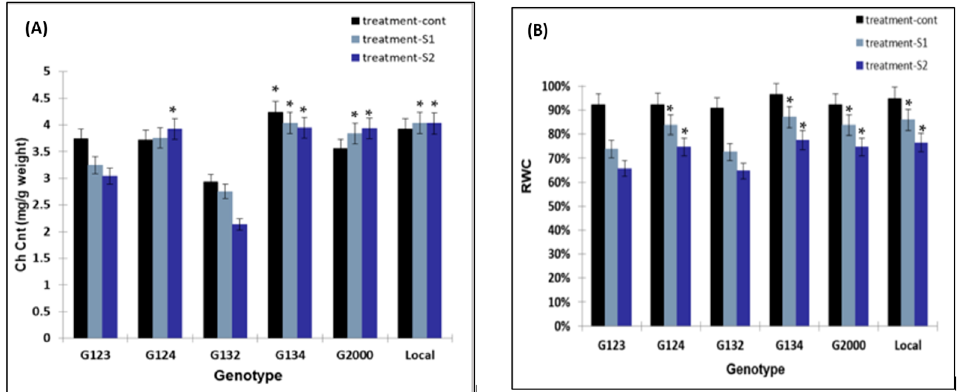
Figure 3. The effect of different NaCl concentrations on the chlorophyll content of the leaves ( A ) after 8 days of sprouting and ( B ) the RWC. * Means significant difference between the genotypes at probability level of